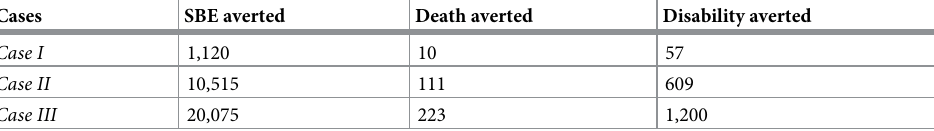
Table 8. Simulations showing the impact and effectiveness of public health awareness over the period of 12